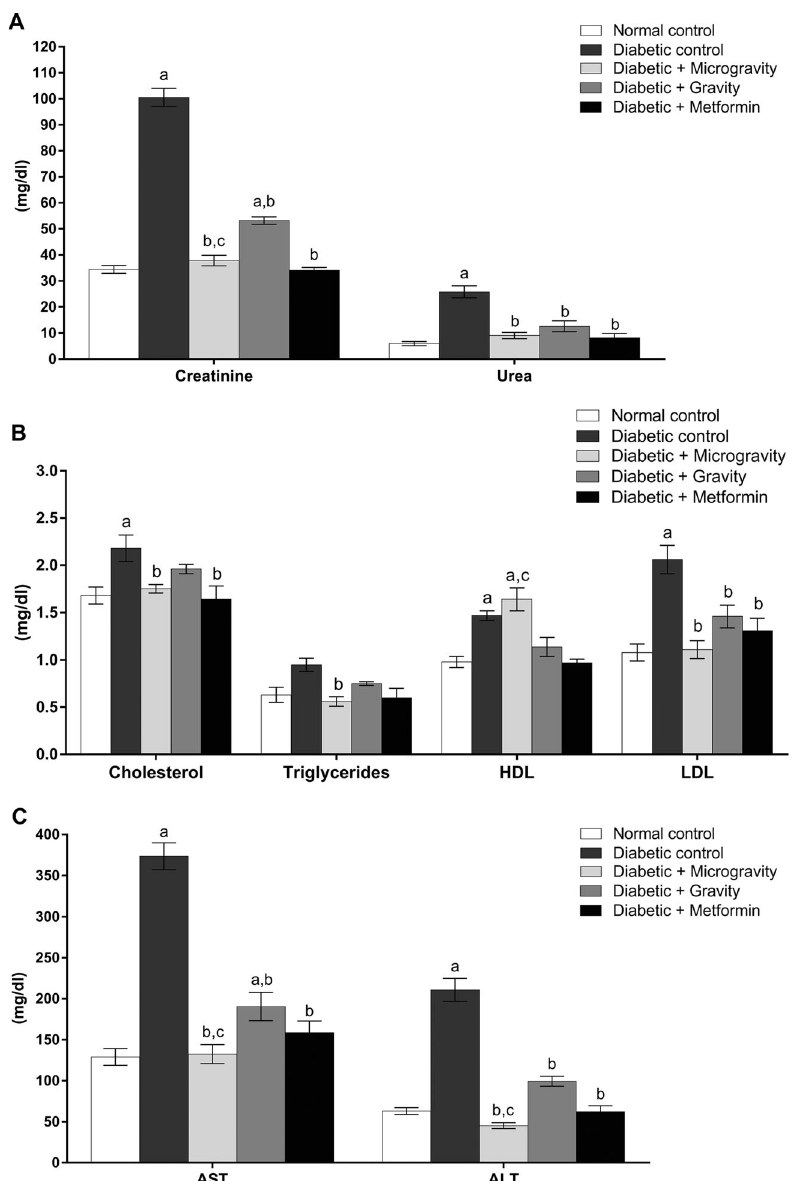
Fig. 5 Effect of treatment with ethanolic extracts of T. aestivum under gravity and microgravity conditions for 30 days on liver and kidney functions and lipid pro fi les in experimental rats. a shows the effect of ethanolic extracts of T. aestivum under gravity and microgravity conditions on biomarkers of kidney function in experimental rats. b shows the effect of ethanolic extracts of T. aestivum under gravity and microgravity conditions on the lipid pro fi les of experimental rats. c shows the effect of ethanolic extracts of T. aestivum under gravity and microgravity conditions on biomarkers of liver function in experimental rats. The values are expressed as the mean ± SEM of seven rats in each group. Data were analyzed by using two-way ANOVA, followed by Tukey ’ s multiple comparison test with the level of signi fi cance set at P < 0.05. a refers to treatment versus normal control, b refers to treatment versus diabetic control, and c refers to microgravity versus